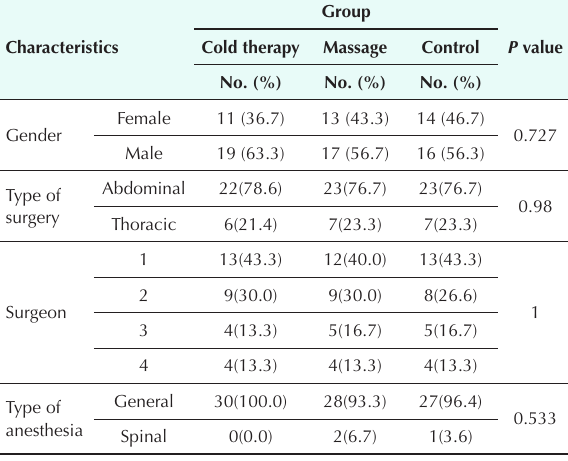
Table 1 . Group comparisons respecting participants’